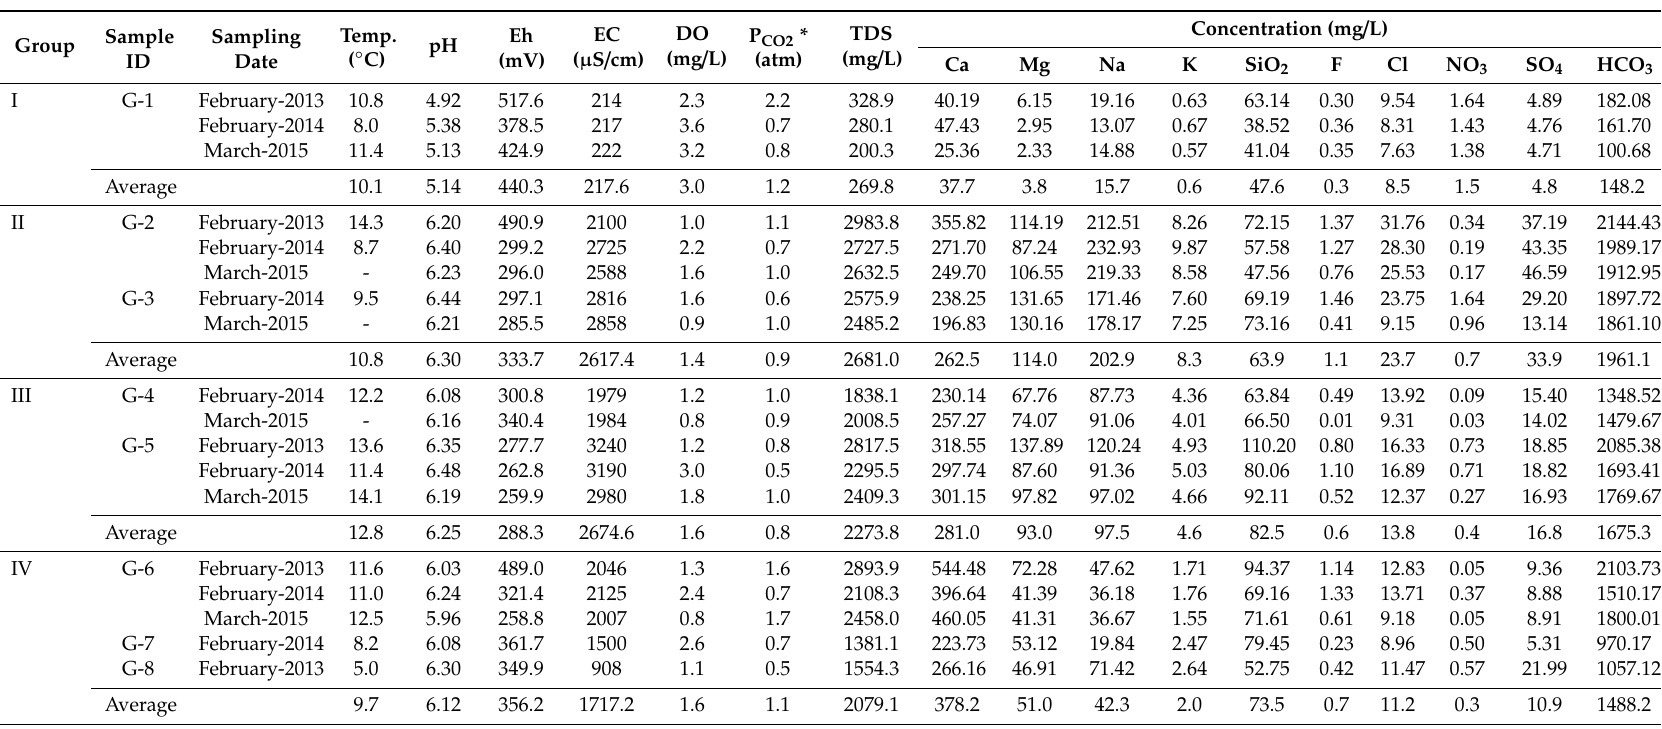
Table 1. Physicochemical data of water samples from the CO 2 -rich springs (n = 8) in the northern part of the GSB. The CO 2 -rich springs are grouped based on pH, TDS, and Na contents in Figure 2. Group I: dilute and acidic CO 2 -rich water; Group II: “Na-enriched” Ca-HCO 3 type water; Group III: “intermediate” Ca-HCO 3 type water; Group IV: “Na-depleted” Ca-HCO 3 type